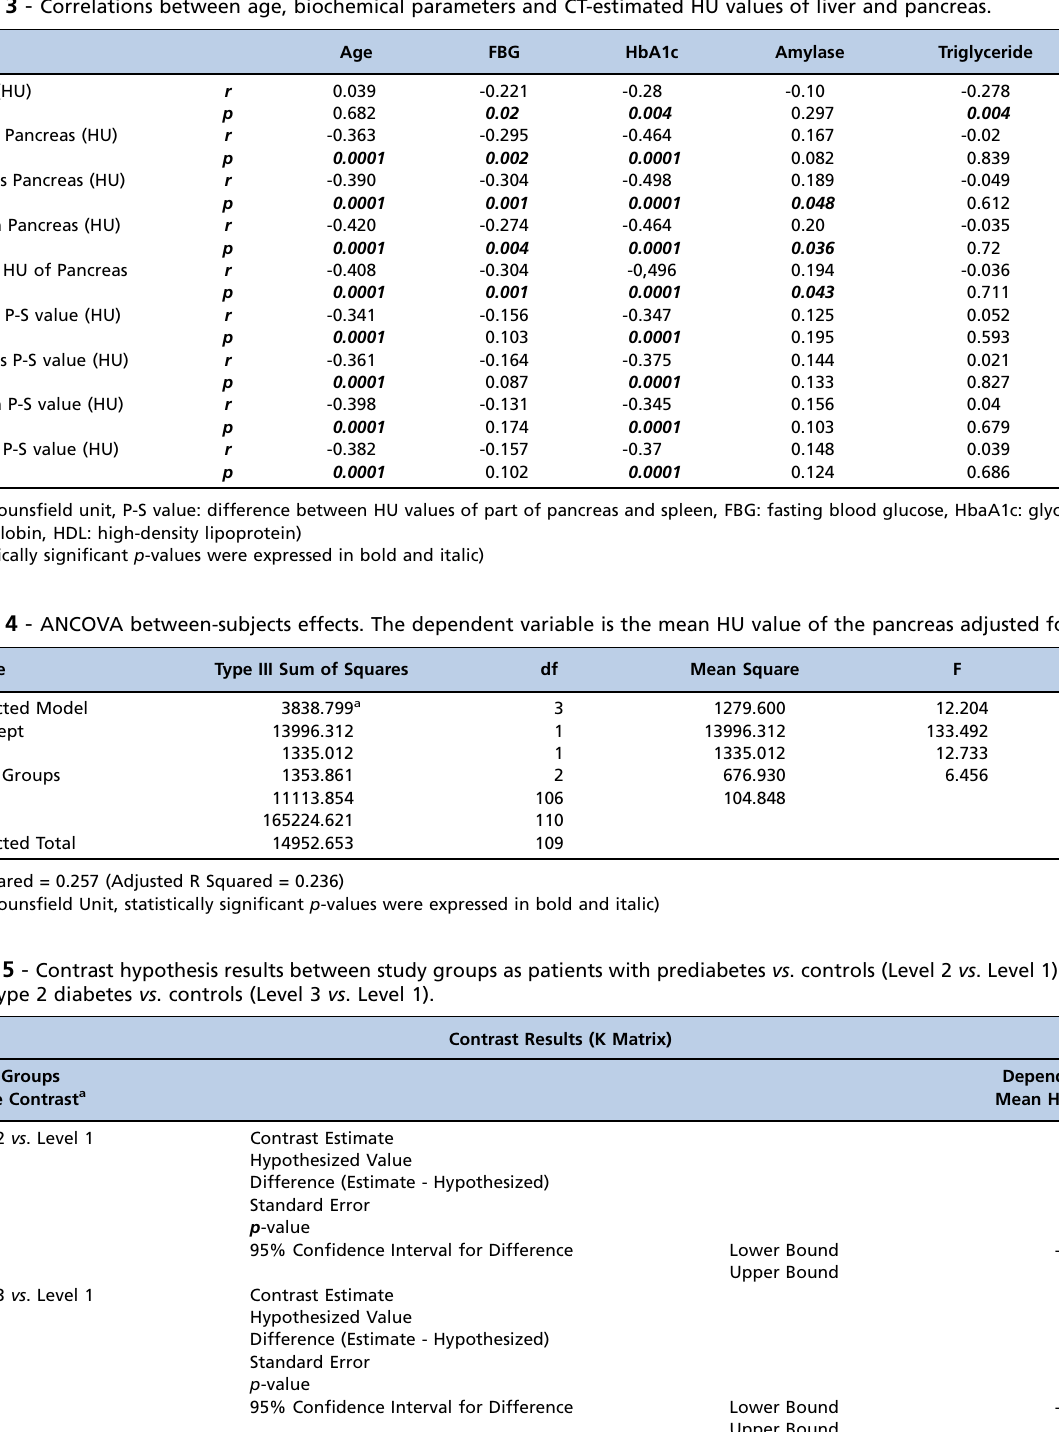
Table 3 - Correlations between age, biochemical parameters and CT-estimated HU values of liver and pancreas.